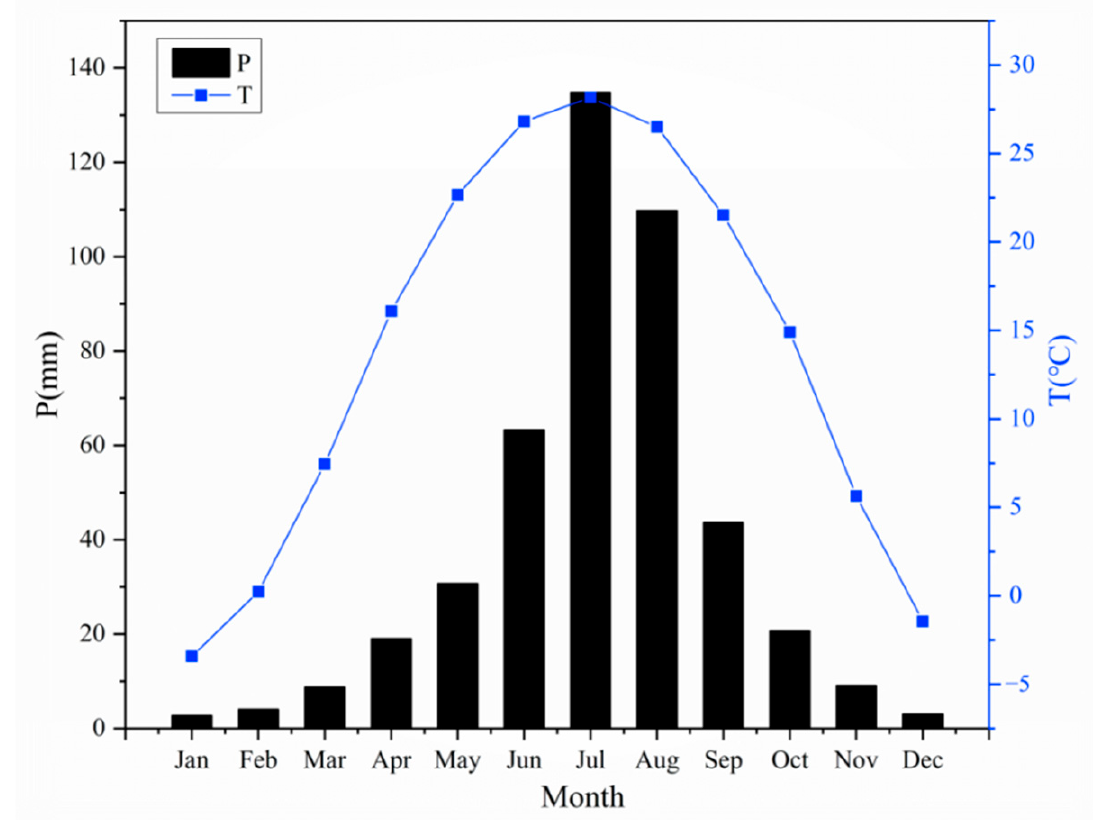
Figure 2. Mean monthly precipitation (P) and monthly maximum temperature (Tmax) in the North China Plain (NCP) during